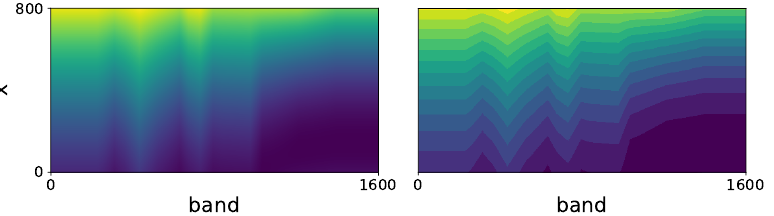
Figure A2. Frame-sized shift matrices where brighter color indicates greater shift distance: ( Left ) floating-point presentation; and ( Right ) values rounded to nearest integer. Rounding causes clearly visible